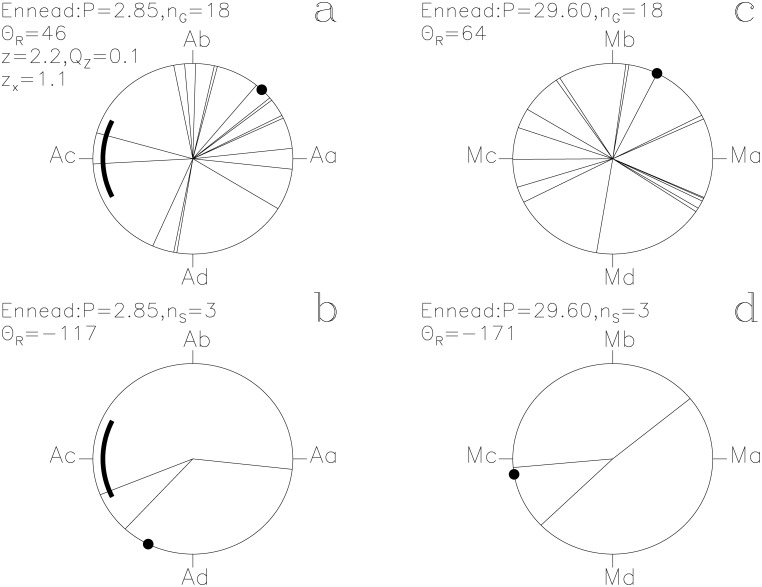
Ennead.otherwise as in Fig 1